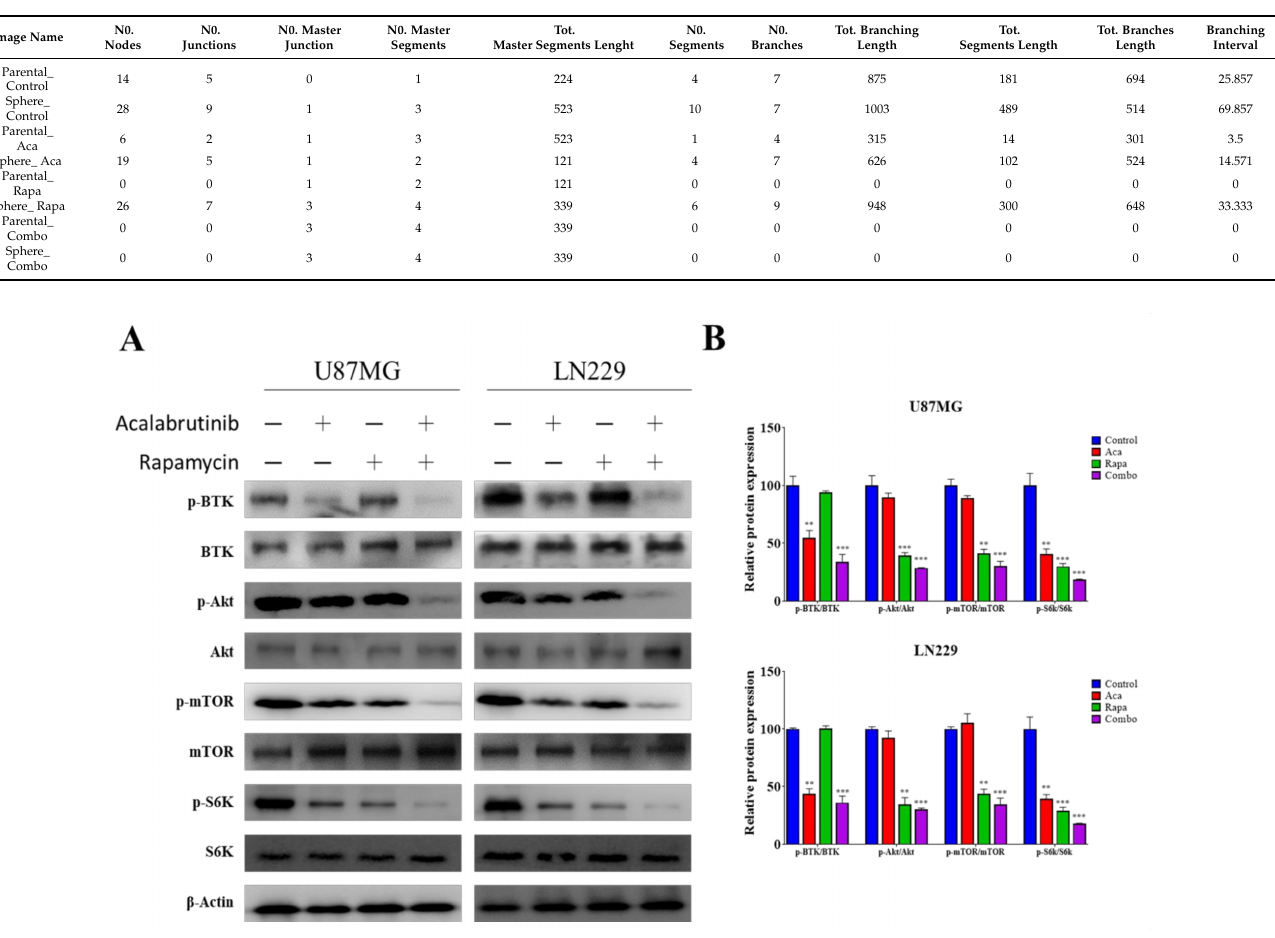
Figure 5. A combination of acalabrutinib and rapamycin exerted inhibitory effects on oncogenic signaling pathways in GBM cell lines. ( A ) The combination enhanced the suppression of the p-BTK, p-Akt, Akt, p-mTOR, mTOR, p-S6K and S6K protein expression levels in GBM cell lines. ( B ) Quantification of the drug combination effect showing the synergism of the drugs in the inhibition of the mTOR signaling pathway, as evidenced by enhanced phosphorylation inhibition on the protein S6K directly downstream in the mTOR pathway. ** p < 0.01; *** p <